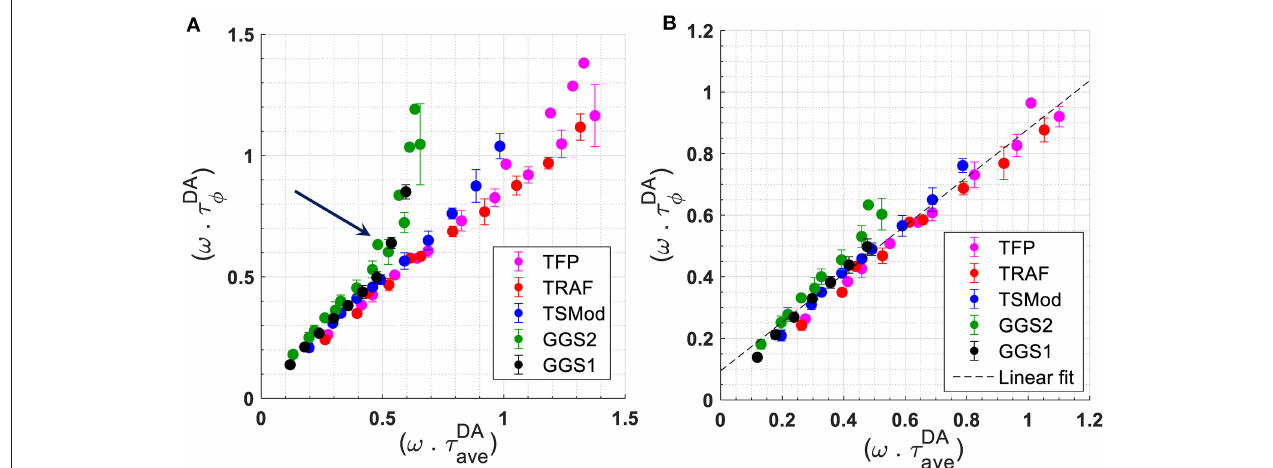
and ω τ DA φ ω τ ave DA for all FRET constructs. For mTFP1, we plotted · · (cid:16) (cid:17) (cid:0) (cid:1) 3.11 ns, and Equation 2. The arrow denotes the point at which the data for GGS1 and GGS2 begin to deviate from a linear = and ω τ DA φ ω τ DA ave for all constructs, and between · · (cid:16) (cid:17) (cid:1) (cid:0)